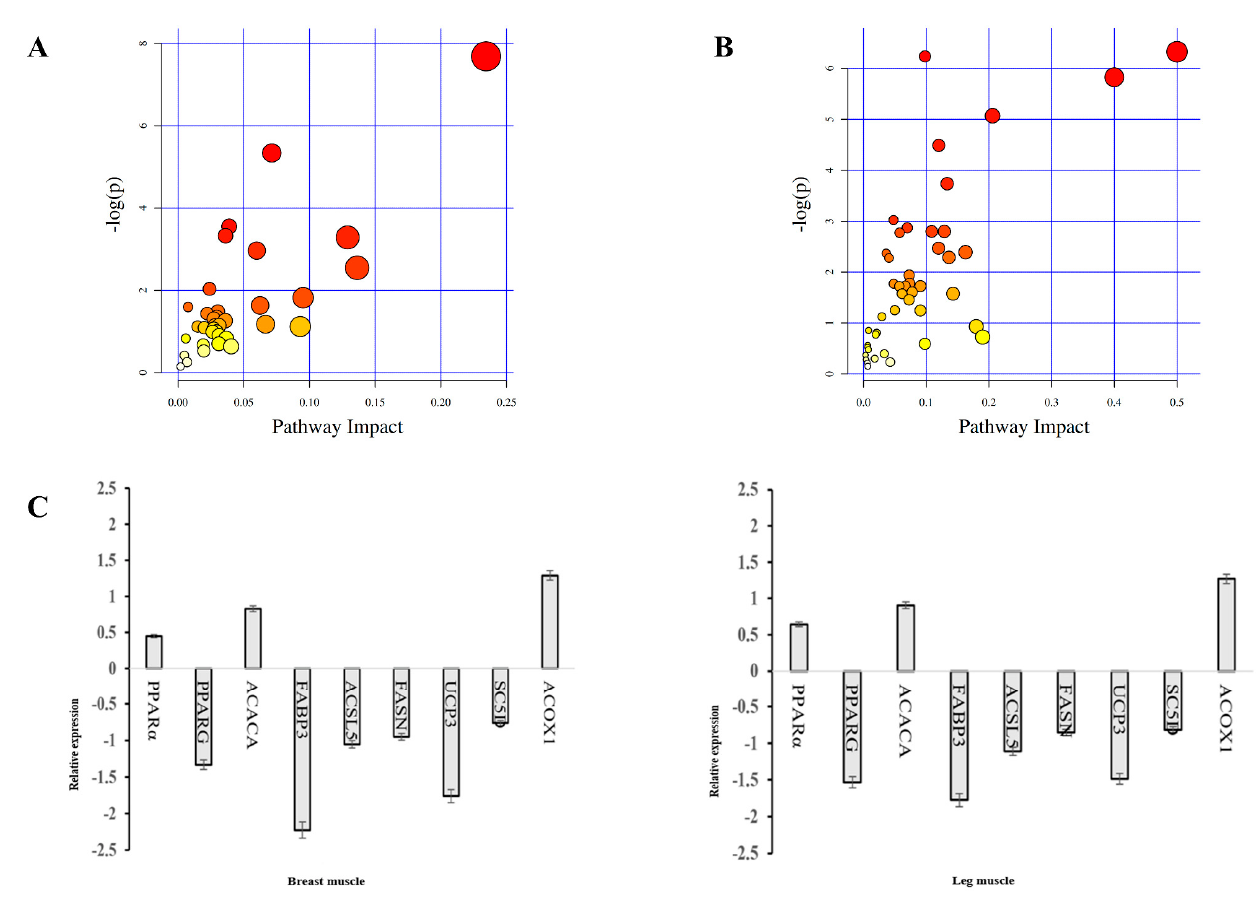
Figure 6. KEGG pathway enrichment. ( A ) Metabolic pathway influencing factors in breast muscle tissue. ( B ) Metabolic pathway influencing factors in leg muscle tissue. ( C ) Relative expression of gene. Table 8. Pathways of KEGG enrichment of different metabolites in breast muscle.